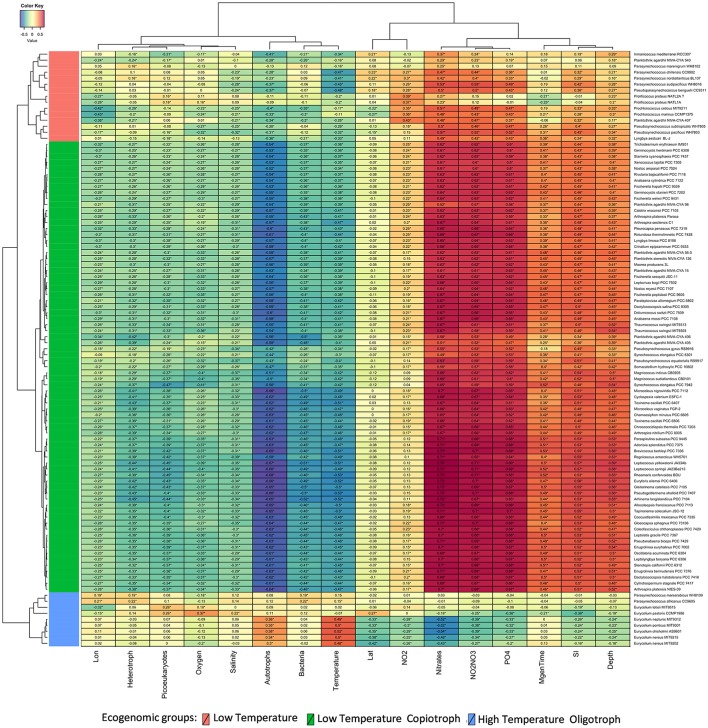
Correlations between Cyanobacteria and environmental variables. Heatmap displays Spearman correlation scores between the abundance of cyanobacterial genomes and measured environmental parameters at Tara Ocean sampling sites. Correlations that showed q corrected p < 0.05 are marked with stars. Variables were grouped through the complete linkage clustering method using Manhattan distances as input. The proposed new genera and species names were adopted in this figure.